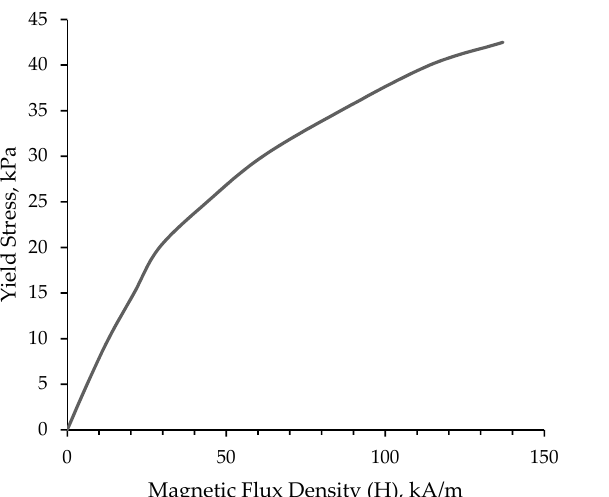
Figure 2. Characterization of MR fluid as yield stress vs Magnetic flux density plot (yield stress curve). Table 1. Properties of MR fluid.